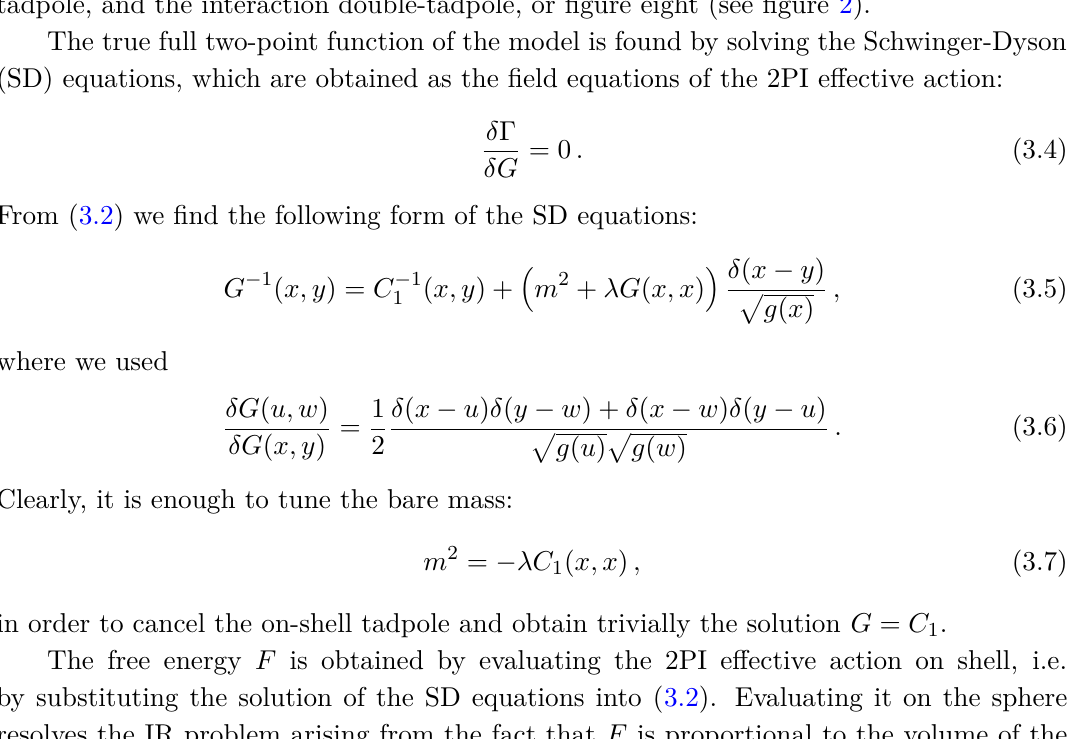
The logarithmic term ln( G − 1 ) should be understood in terms of its eigenvalues (in particu- lar when G coincides or is proportional to the free propagator C around the free